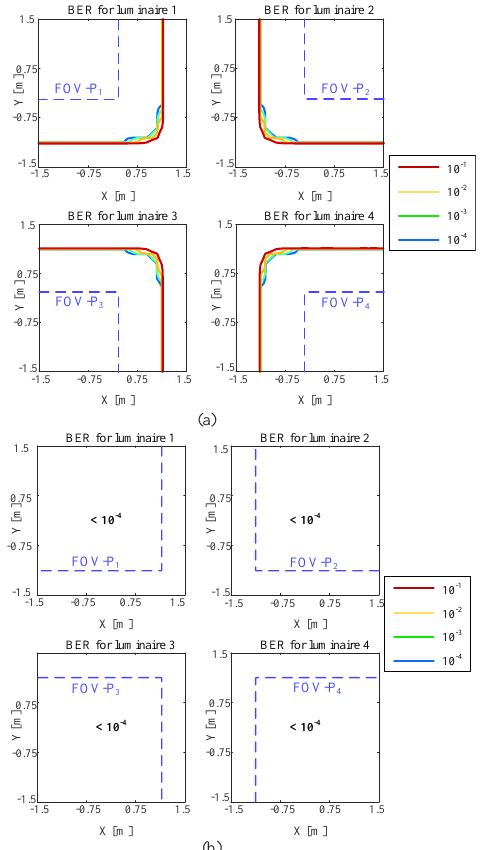
Figure 13. BER versus QADA location in a room equipped with four luminaires when a spectral (cid:0) (cid:1) irradiance of p n = 0.29 µ W/ cm 2 .nm and with the receiver parallel to the plane on which the luminaire is located with a FOV-C of ( a ) 45 o ; ( b ) 63.4 ◦